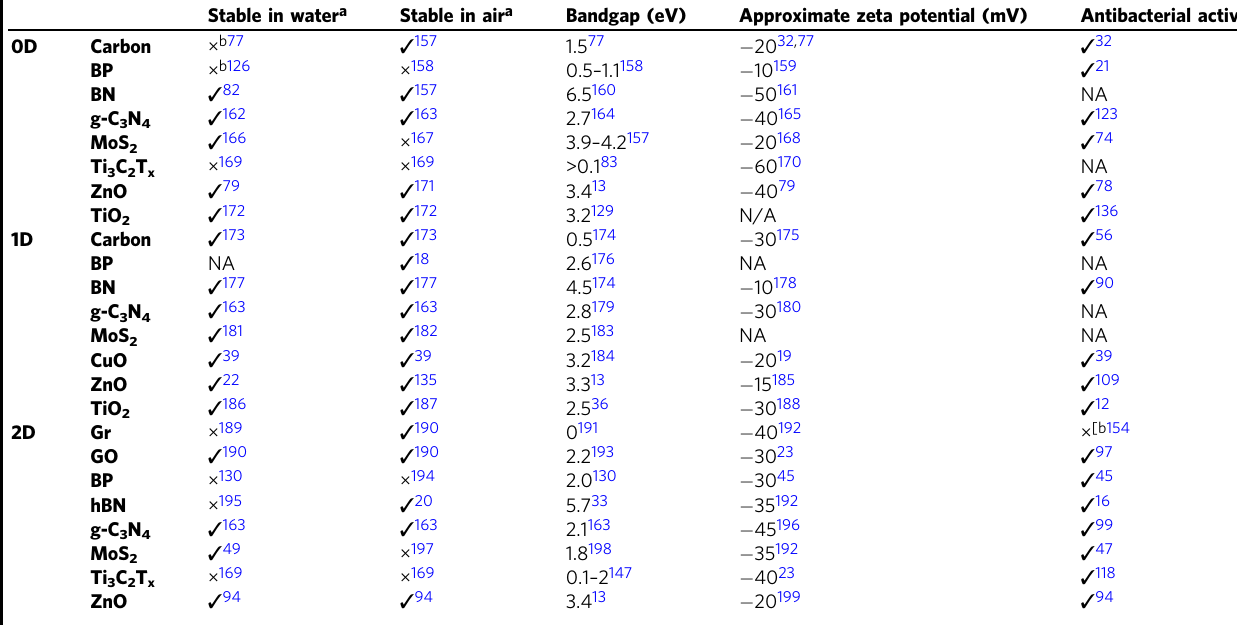
Table 1 Properties of common LDMs.